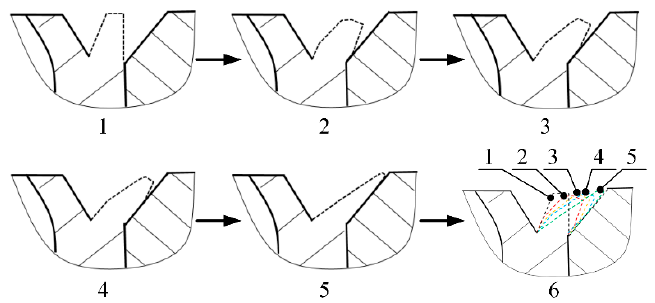
Figure 2. Schematic diagram of the five limit states of the deformation degree of the flanging lip: 1—Initial state; 2—Limit state of “State 2”; 3—Limit state of “State 3”; 4—Limit state of “State